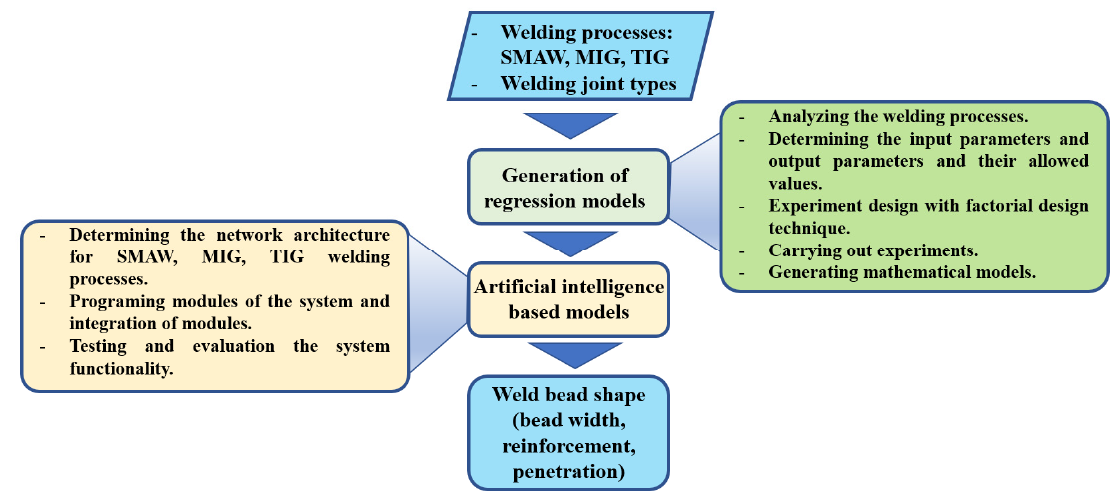
Figure 1. Systematic procedure for developing the predictive system.